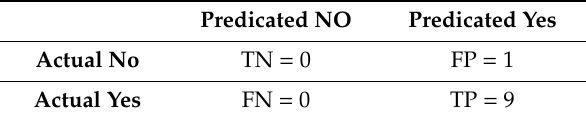
Table 6. Confusion matrix of ocean class.